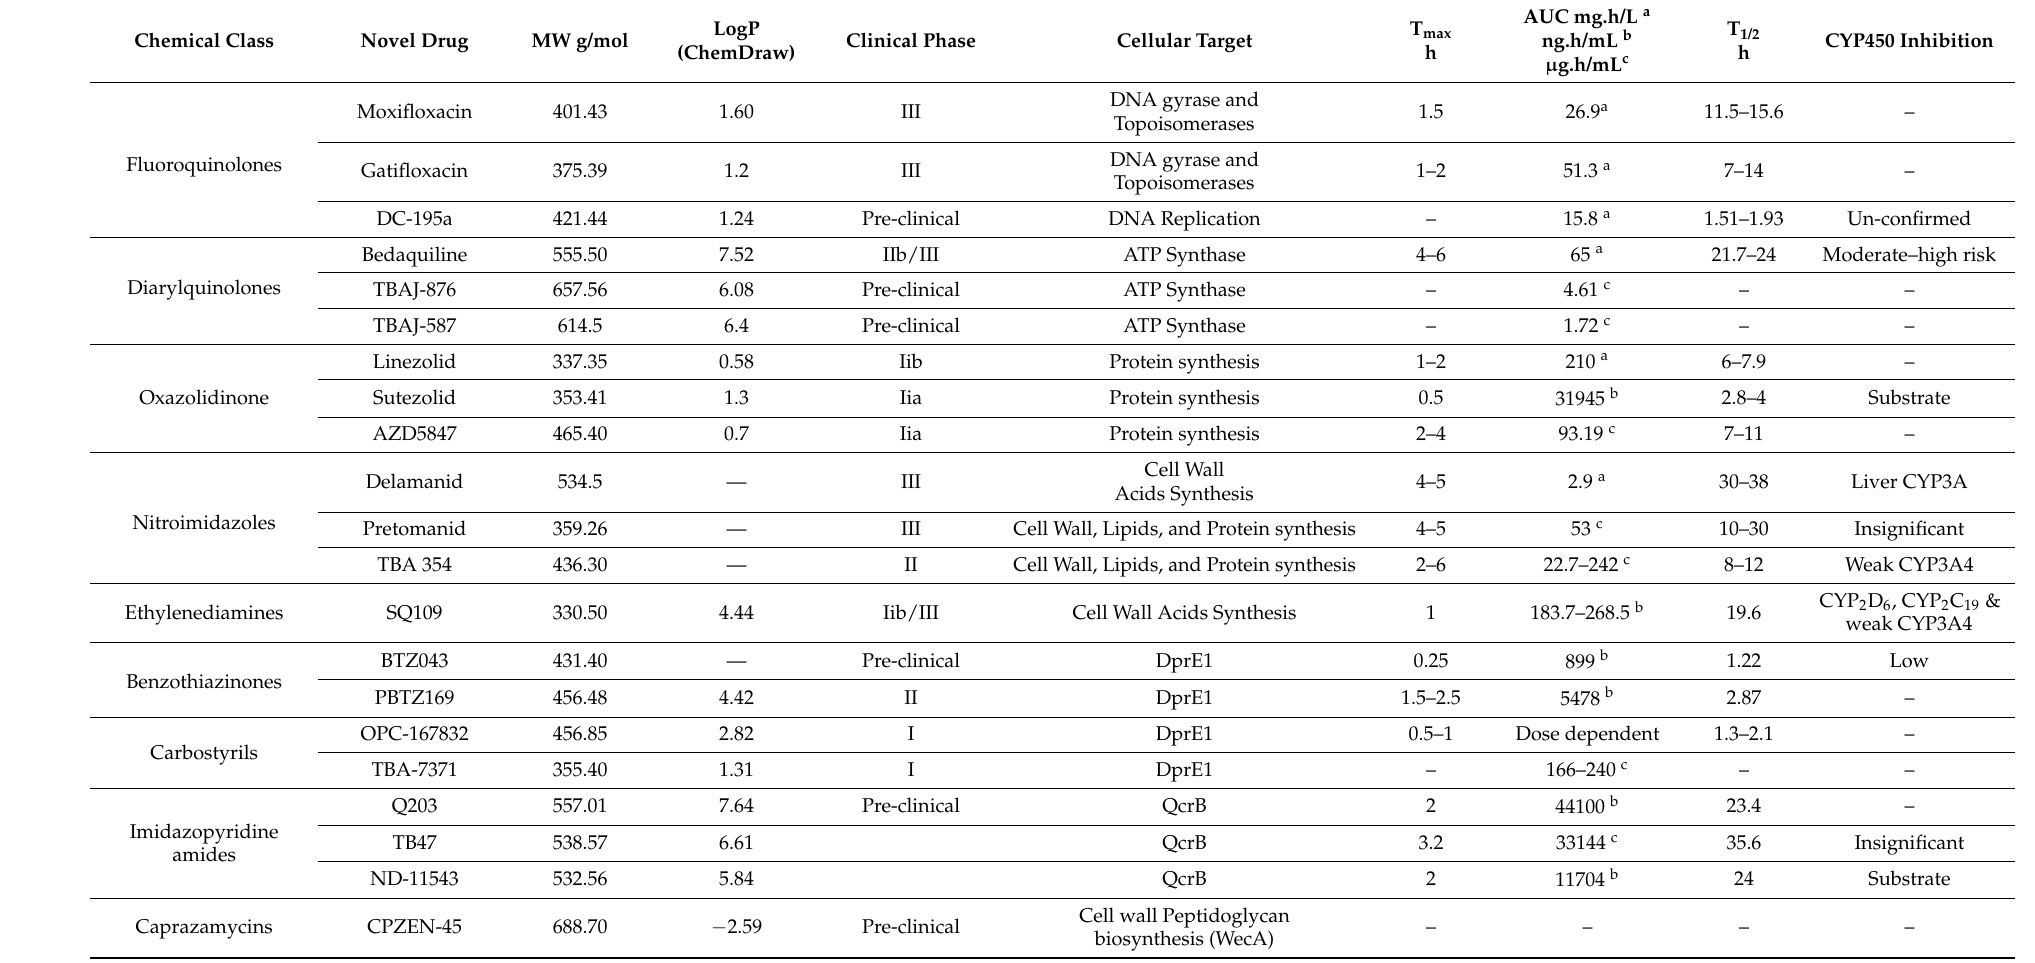
Table 2. Anti-TB drug candidates in different phases of the drug development process: